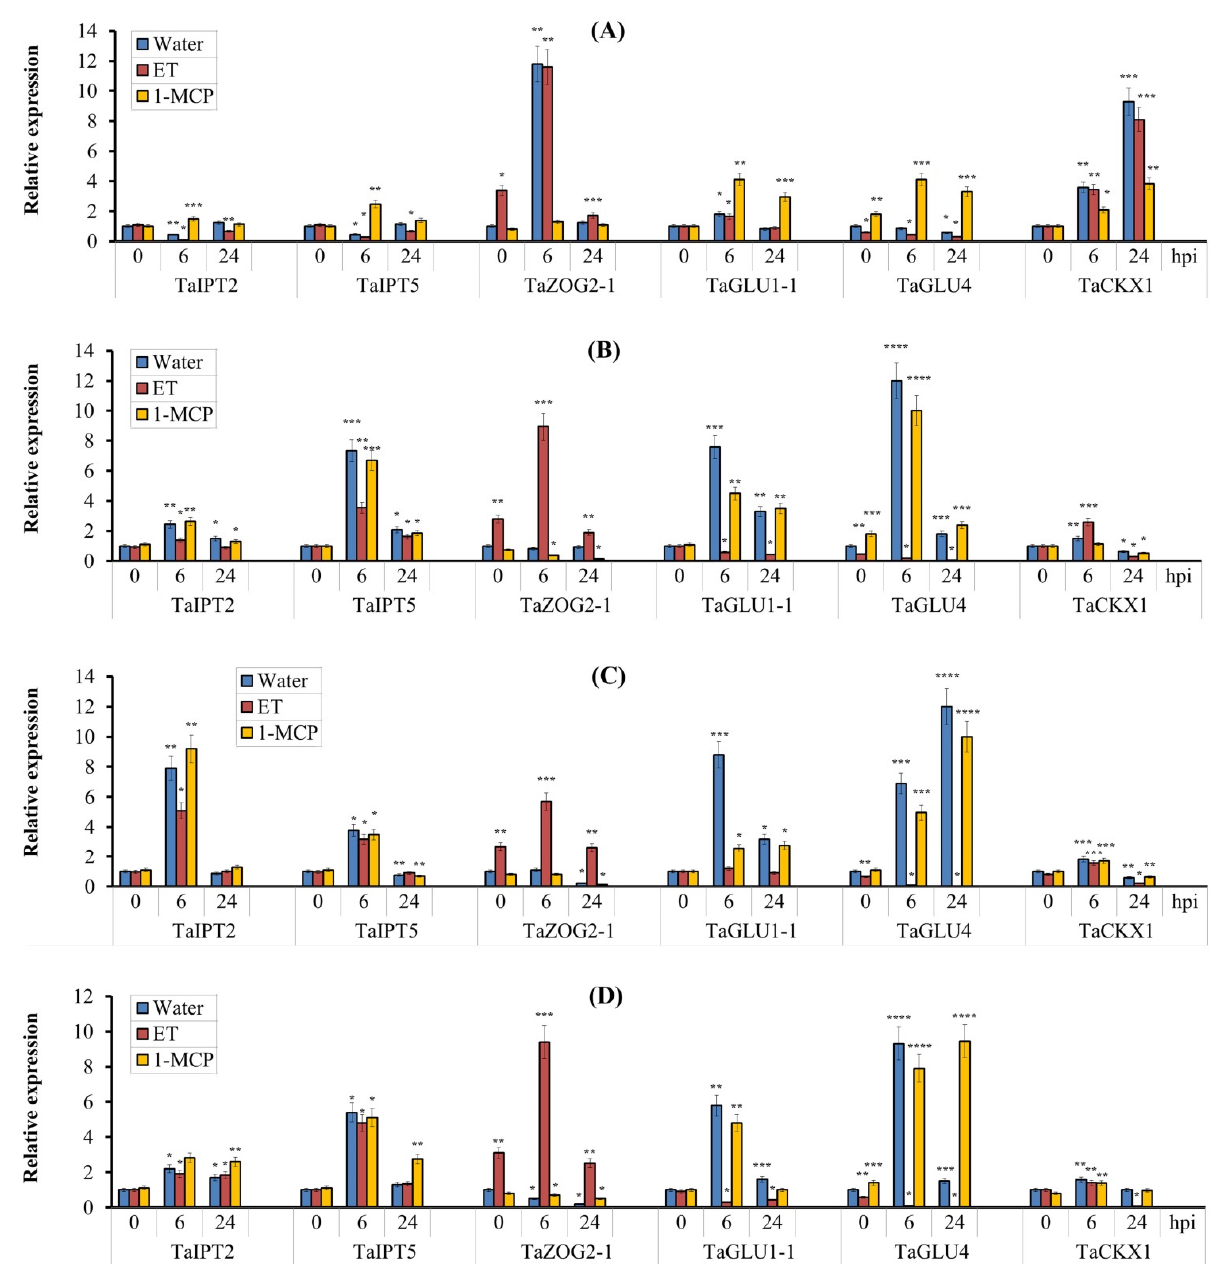
Figure 8. The effect of pretreatment with ethephone (ET) and 1-MCP on the relative expression of genes involved in the biosynthesis ( TaIPT2 , TaIPT5 ), O-glucosylation ( TaZOG2-1 ), deglucosylation ( TaGLU1-1 , TaGLU4 ), and oxidative degradation ( TaCKX1 ) of cytokinins in two wheat cultivars of Kaz10 ( A , C ) and Om35 ( B , D ) infected with virulent SnB ( A , B ) and avirulent Sn4VD S. nodorum isolates ( C , D ). Expression values were normalized to the housekeeping gene TaRLI as an internal reference and expressed relative to the normalized expression levels in mock-treated control (water) plants at 0 hpi. Symbols are the same as in Figure 2. Figures present means ± SE (n = 6). Asterisks indicate means statistically different from the control and different number of asterisks allows (*, **, ***, ****) distinguishing of significantly different variants according to the LSD test at * p < 0.05, ** p < 0.01, *** p < 0.001, **** p < 0.0001.